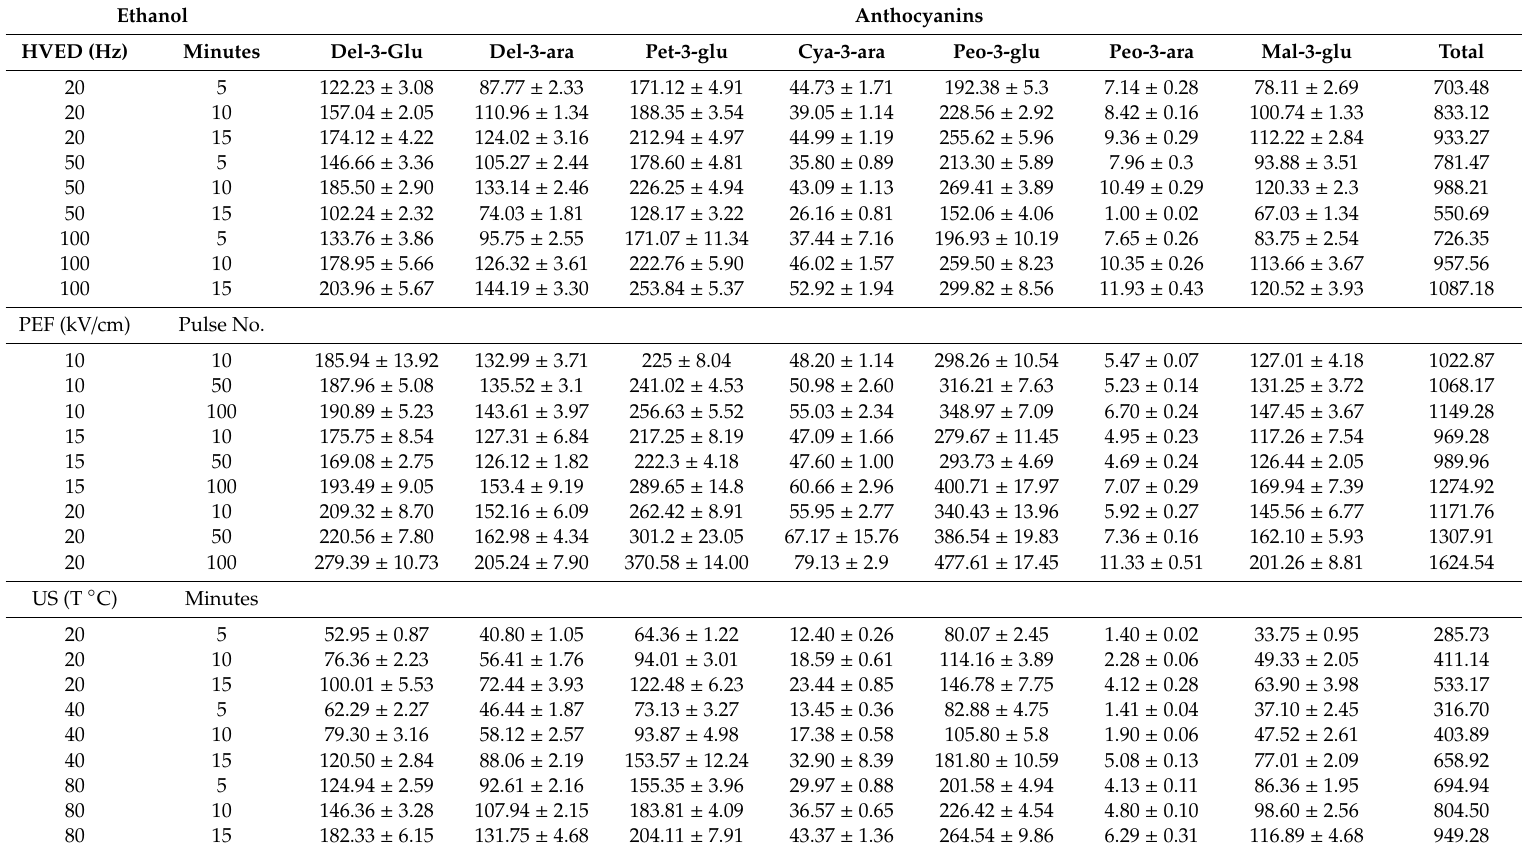
Table 2. The anthocyanins content ( µ g / g of dw) in extracts obtained after high voltage electrical discharges (HVED), pulsed electric field (PEF), and ultrasound-assisted extraction (UAE) of blueberry